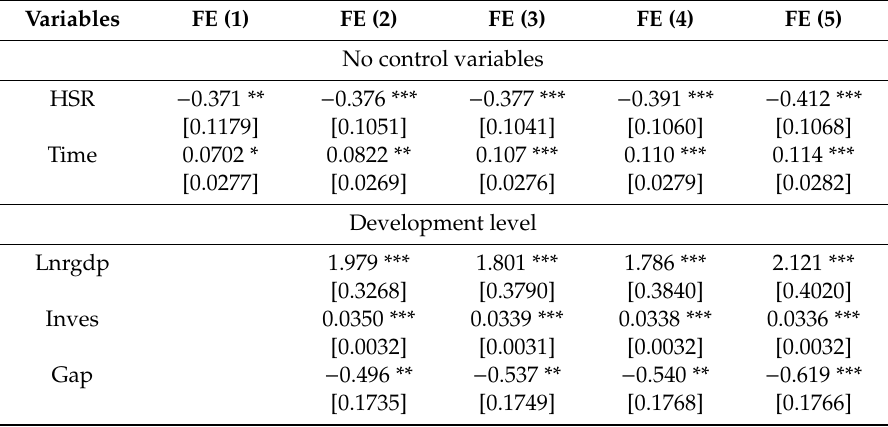
Table 3. Test of the direct e ff ect of the HSR